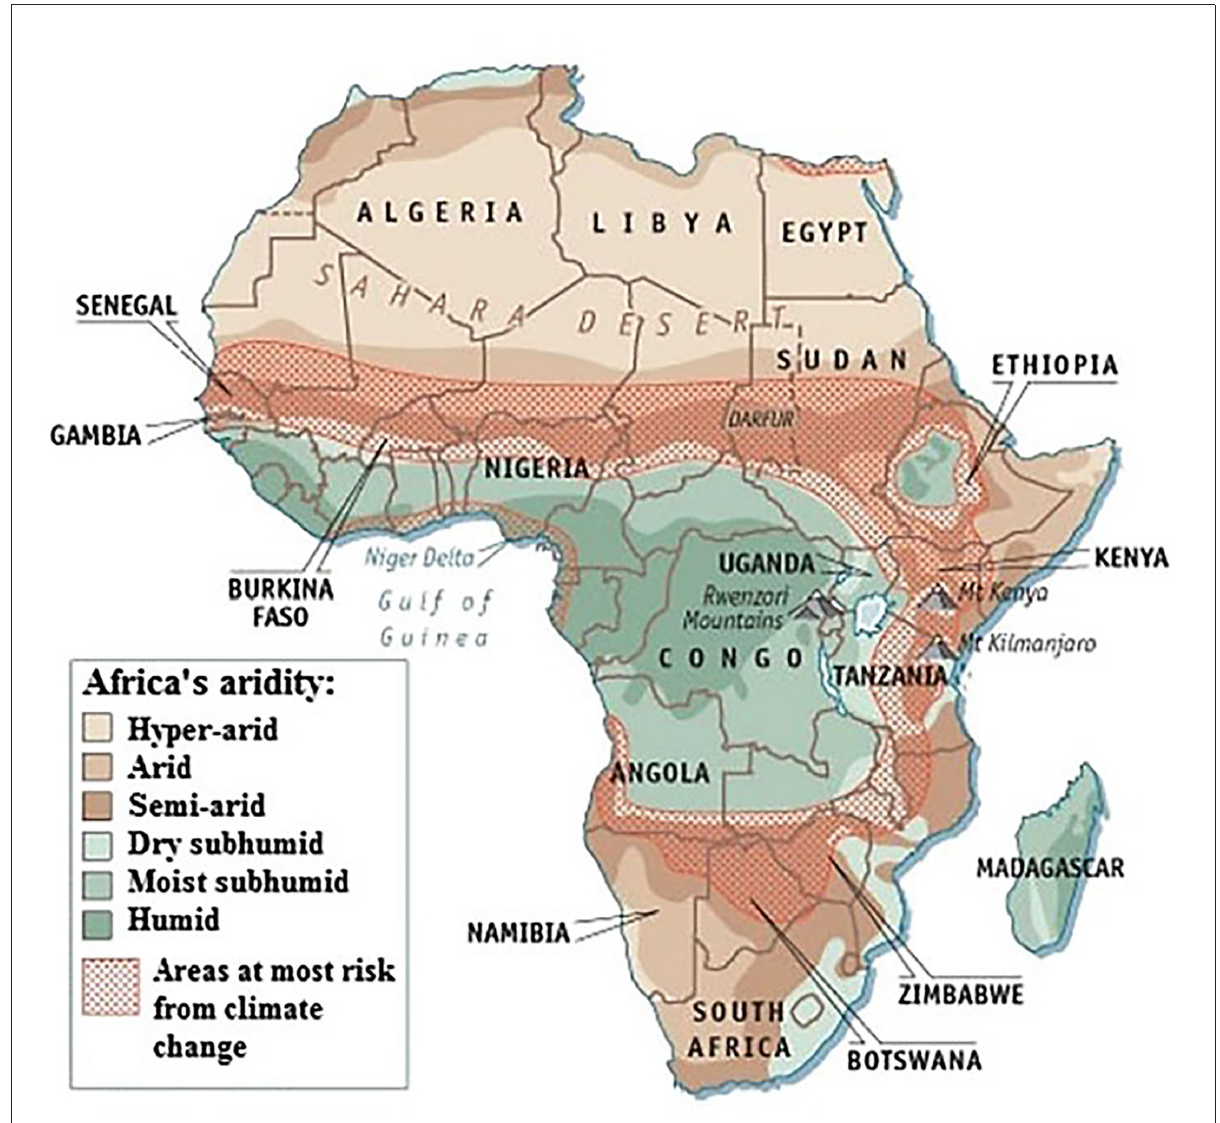
FIGURE1 Map of Africa showing countries at risk of climate change facilitated water stresses. Source: http://kenvironews.wordpress.com/2007/08/31/